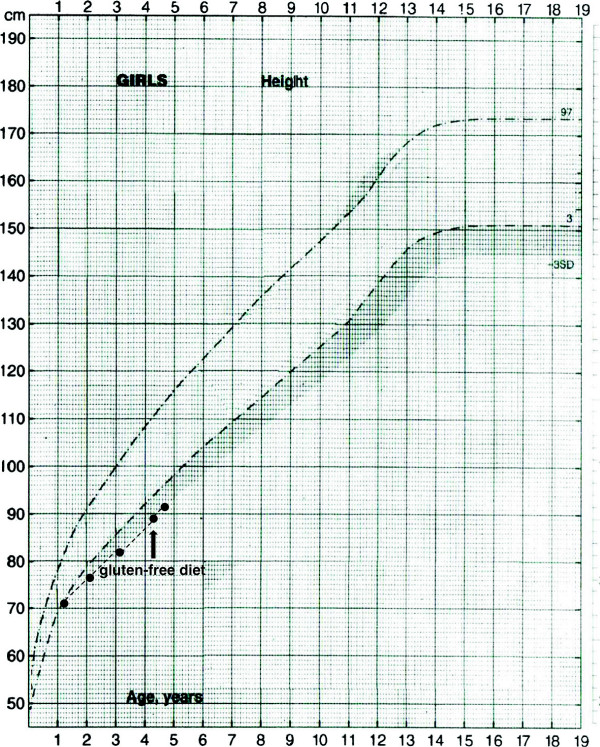
Height curve of the subject. The arrow indicates the start of the gluten-free diet.